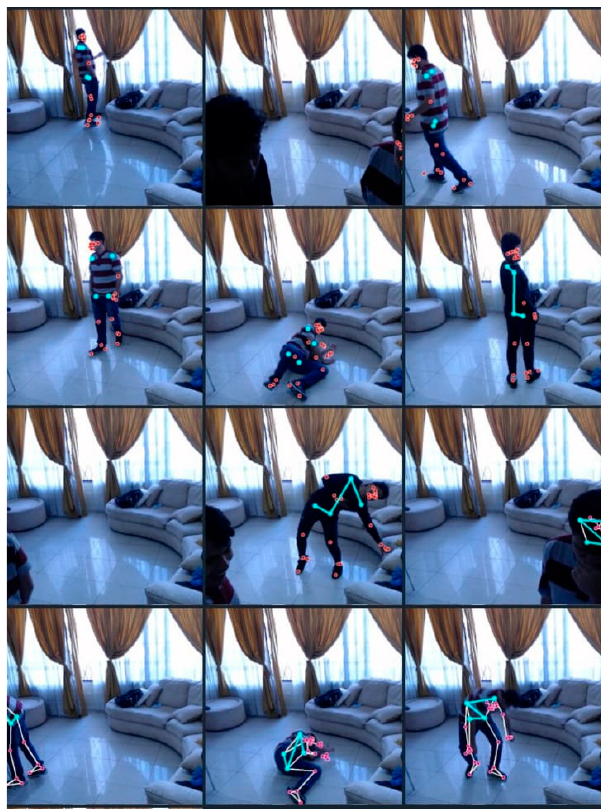
Figure 6. Fall detection sequence.